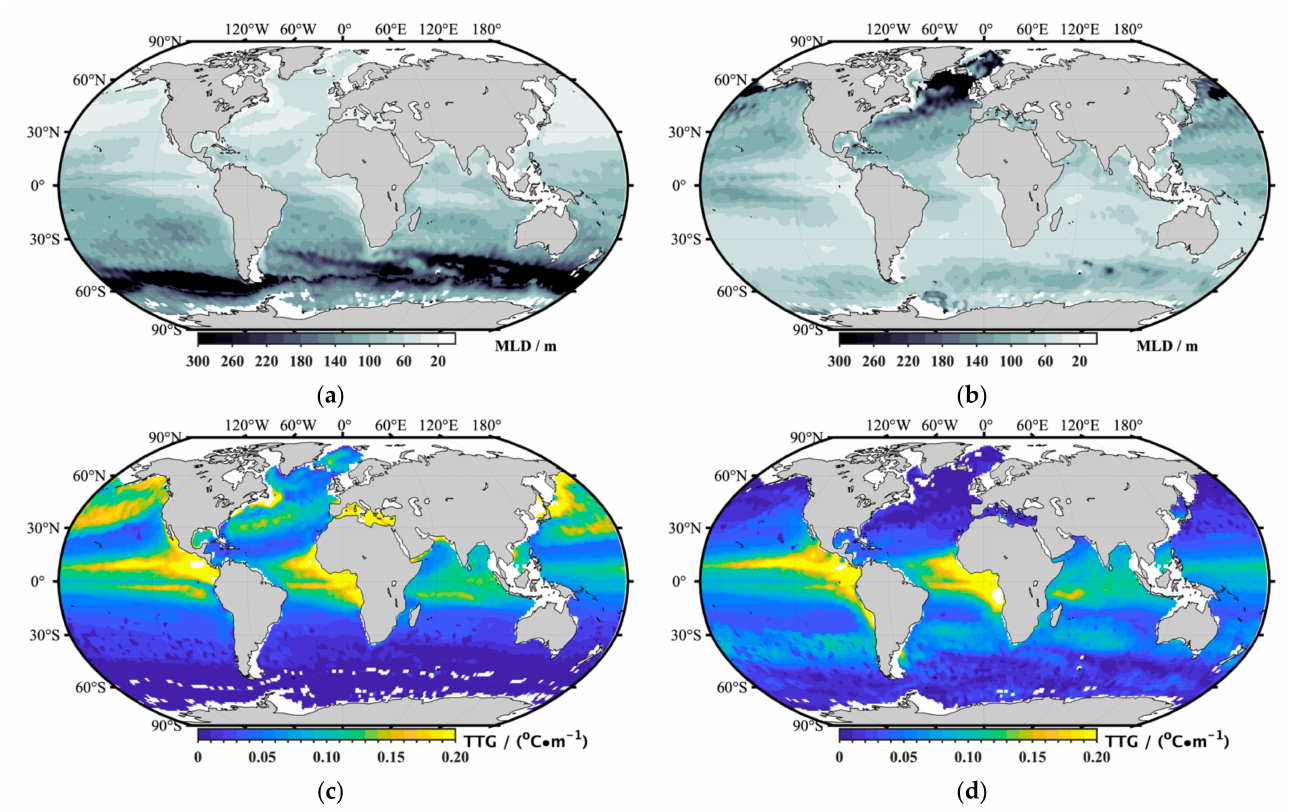
Figure 10. The characteristics of the mixed layer depth (MLD) and the temperature thermocline gradient (TTG) in summer and winter in the global ocean: ( a ) summer MLD; ( b ) winter MLD; ( c ) summer TTG; ( d ) winter